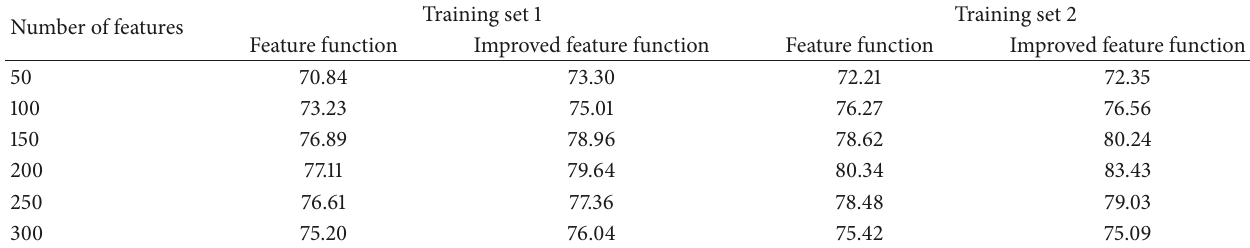
Table 1: Micro-average accuracy comparison among different training sets.